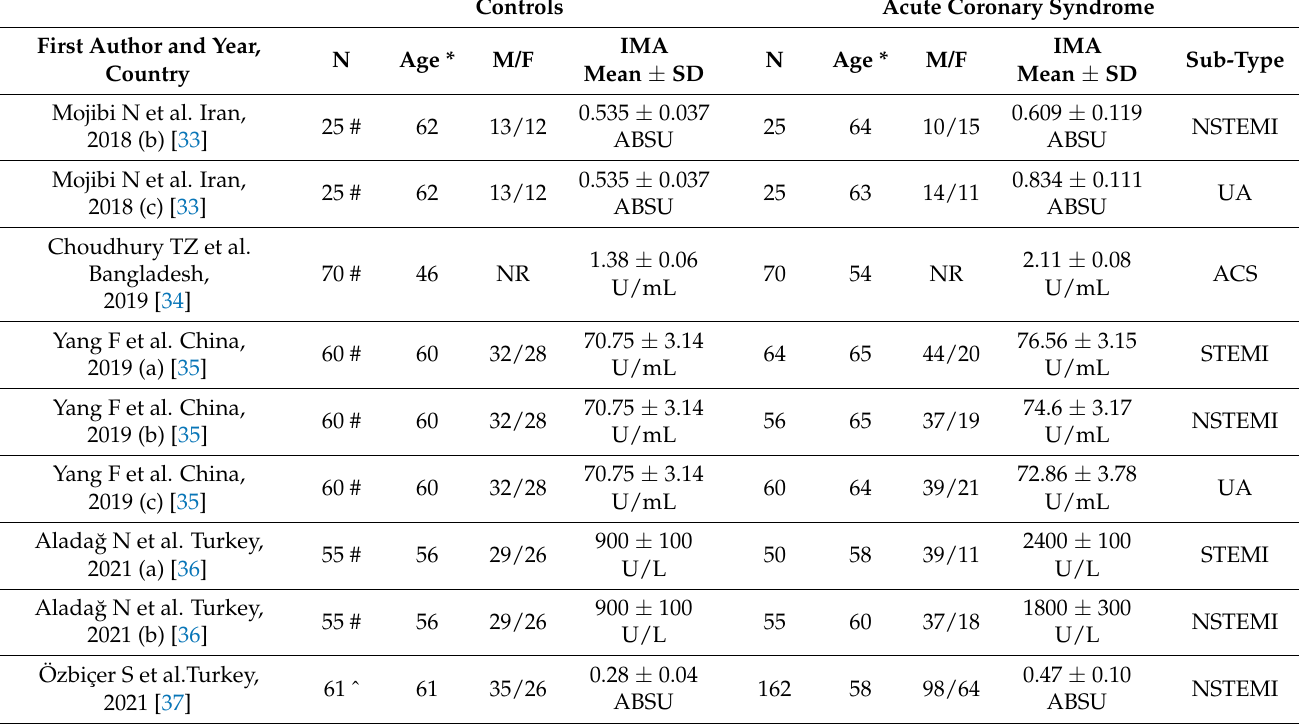
Figure 2. In two comparator arms from the same study, IMA concentrations were either lower in ACS patients, or virtually identical between ACS patients and controls [27]. In the remaining comparator arms, ACS patients had higher IMA concentrations, although the difference was not significant in two [27,37]. There was substantial heterogeneity (I 2 = 97%, p < 0.001). Pooled results showed that IMA concentrations were significantly higher in ACS (SMD = 2.38, 95% CI 1.88 to 2.88; p < 0.001). In the sensitivity analysis, the corresponding pooled SMDs were not substantially altered when individual studies were omitted (effect size range, between 2.10 and 2.47, Figure 3). The funnel plot in Figure 4 revealed a distortive effect of three studies [30,34,36]. Their removal attenuated the effect size (SMD-1.74, 95% CI 1.32 to 2.15; p < 0.001) but not the heterogeneity (I 2 = 95.7%, p <